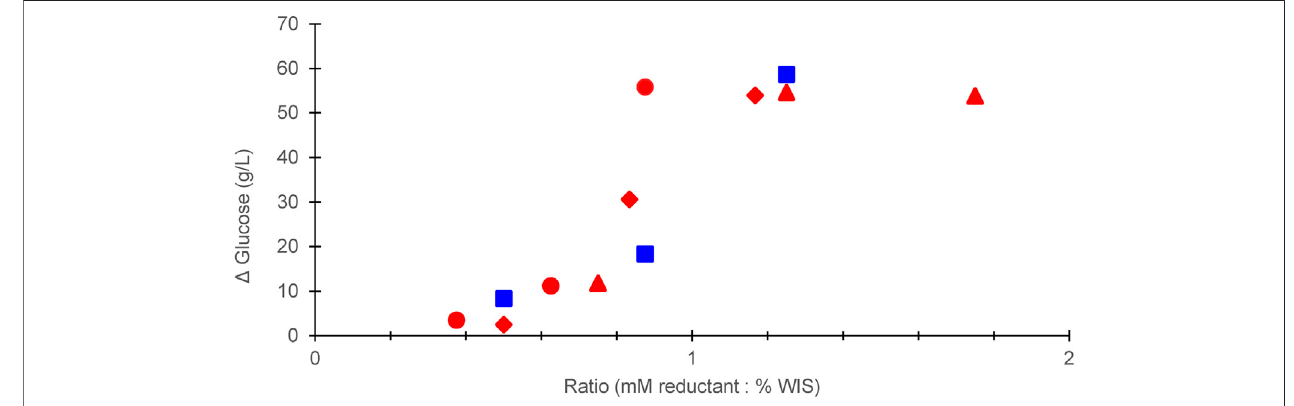
FIGURE 2 | Glucose concentration after 24 h of enzymatic sacchari fi cation in relation to dosage of reductant expressed as the ratio of the reductant (in mM) to the WIS concentration (in %, w/v). The data indicate: sodium sul fi te addition in 10% (w/v) (red triangles), 15% (w/v) (red diamonds), or 20% (w/v) (red circles) WIS slurry; sodium dithionite addition in 10% (w/v) (blue squares) WIS slurry.